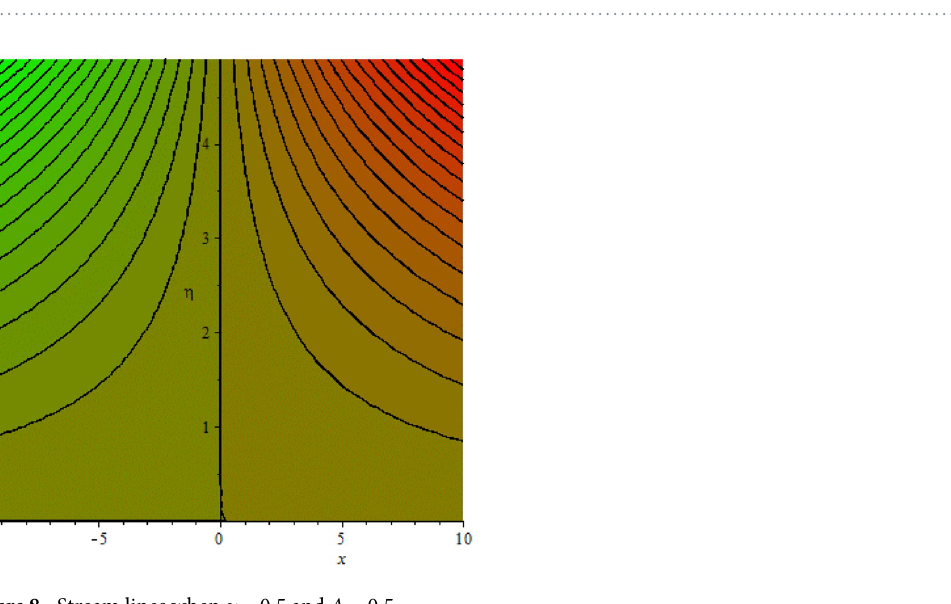
Figure 8. Stream lines when γ = 0.5 and A =